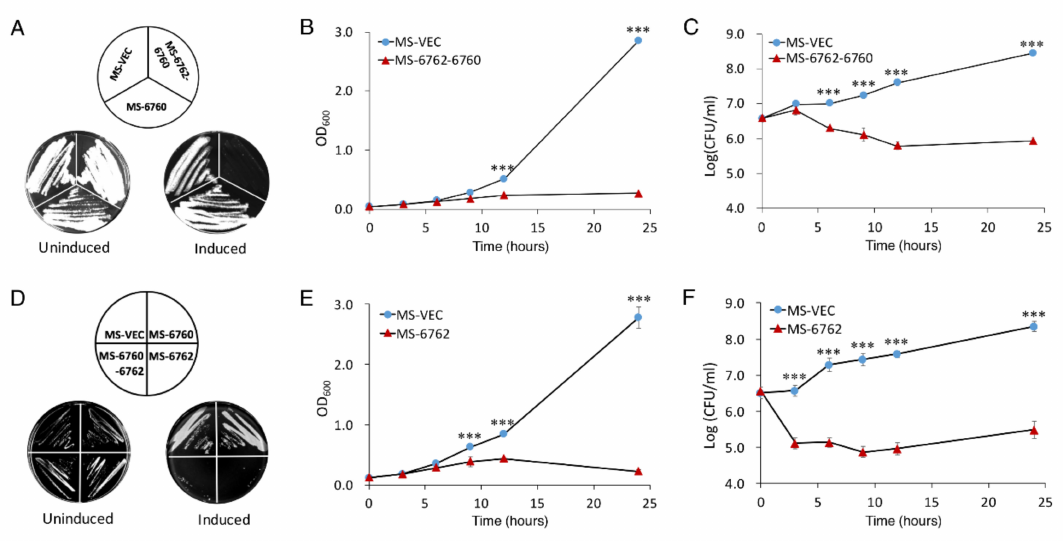
Figure 1. Effect of MSMEG_6760 and MSMEG_6762 on the growth and viability of M. smegmatis . Growth on 7H10 plates with 50 µ g/mL hygromycin without (left) and with (right) 1% acetamide ( A , D ), were incubated for 3 days. M. smegmatis hosts containing pALACE-based constructs were cultured in 7H9 medium supplemented with 50 µ g/ µ L hygromycin without (left) and with (added at OD 600 = 0.1). Cell growth of MS-6762-6760 ( B ), MS-6762 ( E ) and viability (CFU/mL) of MS-6762- 6760 ( C ), MS-6762 ( F ) were tested at indicated intervals. MS-VEC, M. smegmatis with pALACE plasmid. MS-6062, M. smegmatis with pALACE- MSMEG_6760 - MSMEG_6762 plasmid. MS-6762: with pALACE- MSMEG_6762 plasmid. Experiments were performed in triplicate. Data are represented as mean +/ − SEM. Significance of MS-VEC strain compared to MS-6762 strain was determined using a Student’s t test: *** p <